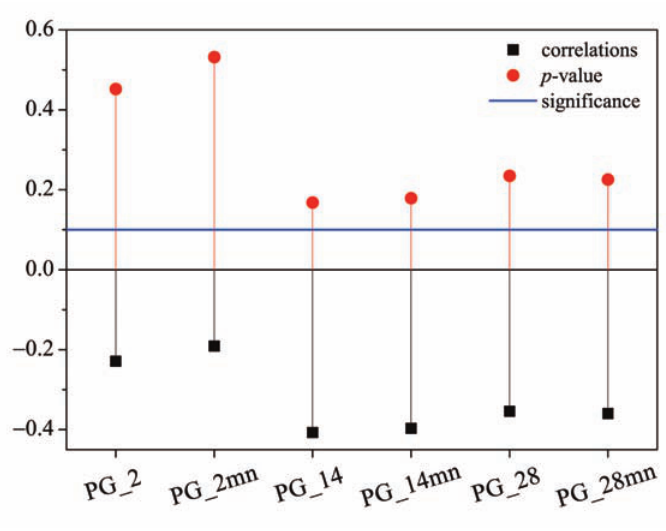
Figure 4. Statistics relating to the PG and S